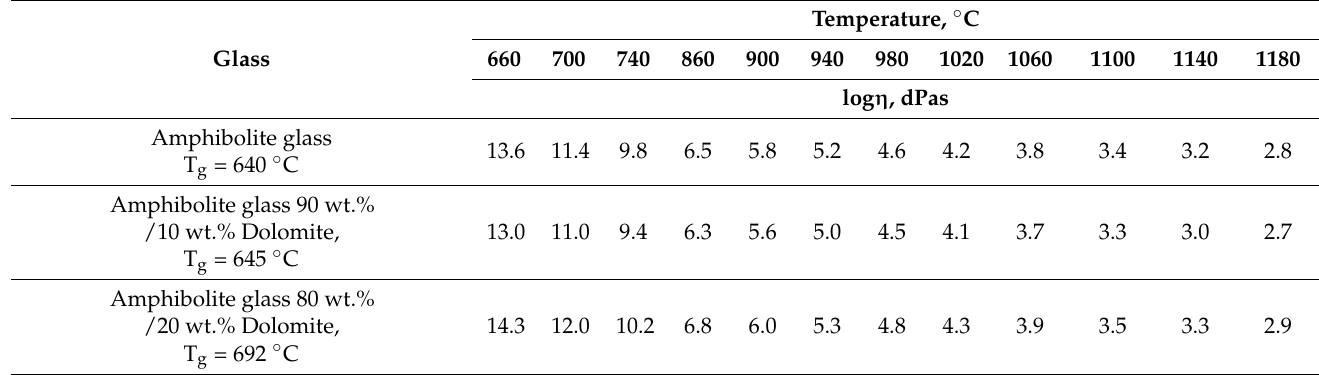
Table 4. Viscosity coefficients of glasses determined by the one-point method.